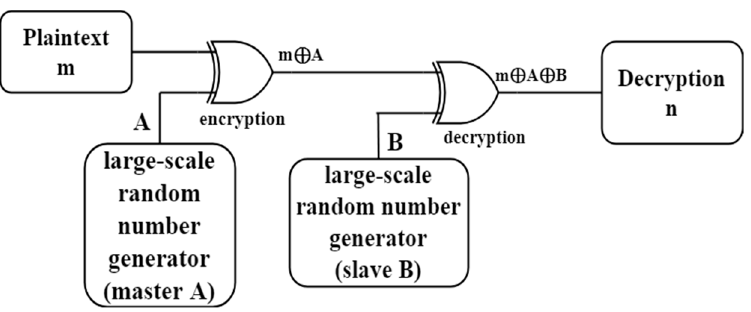
Figure 15. The structure of encryption and decryption mechanism.